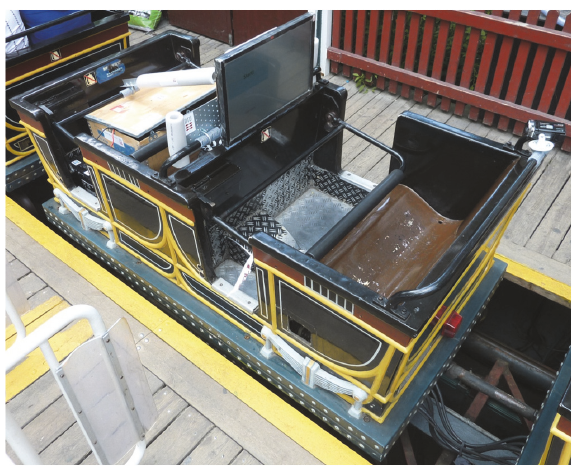
Figure 3: Experimental setup on a wagon of the